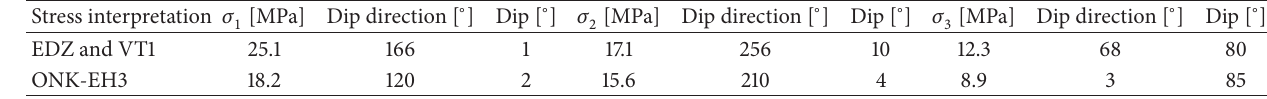
Table 1: EDZ and VT1 and ONK-EH3 in situ stress state interpretations at depth − 345m.